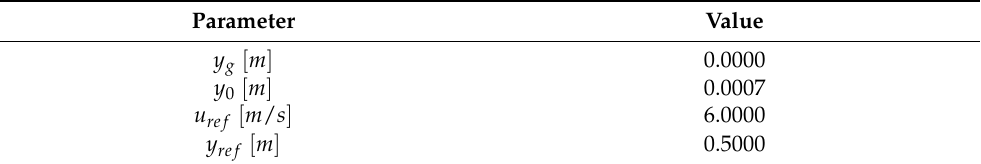
Table A2. Values of the atmospheric boundary layer parameters used in inlet profiles [28].